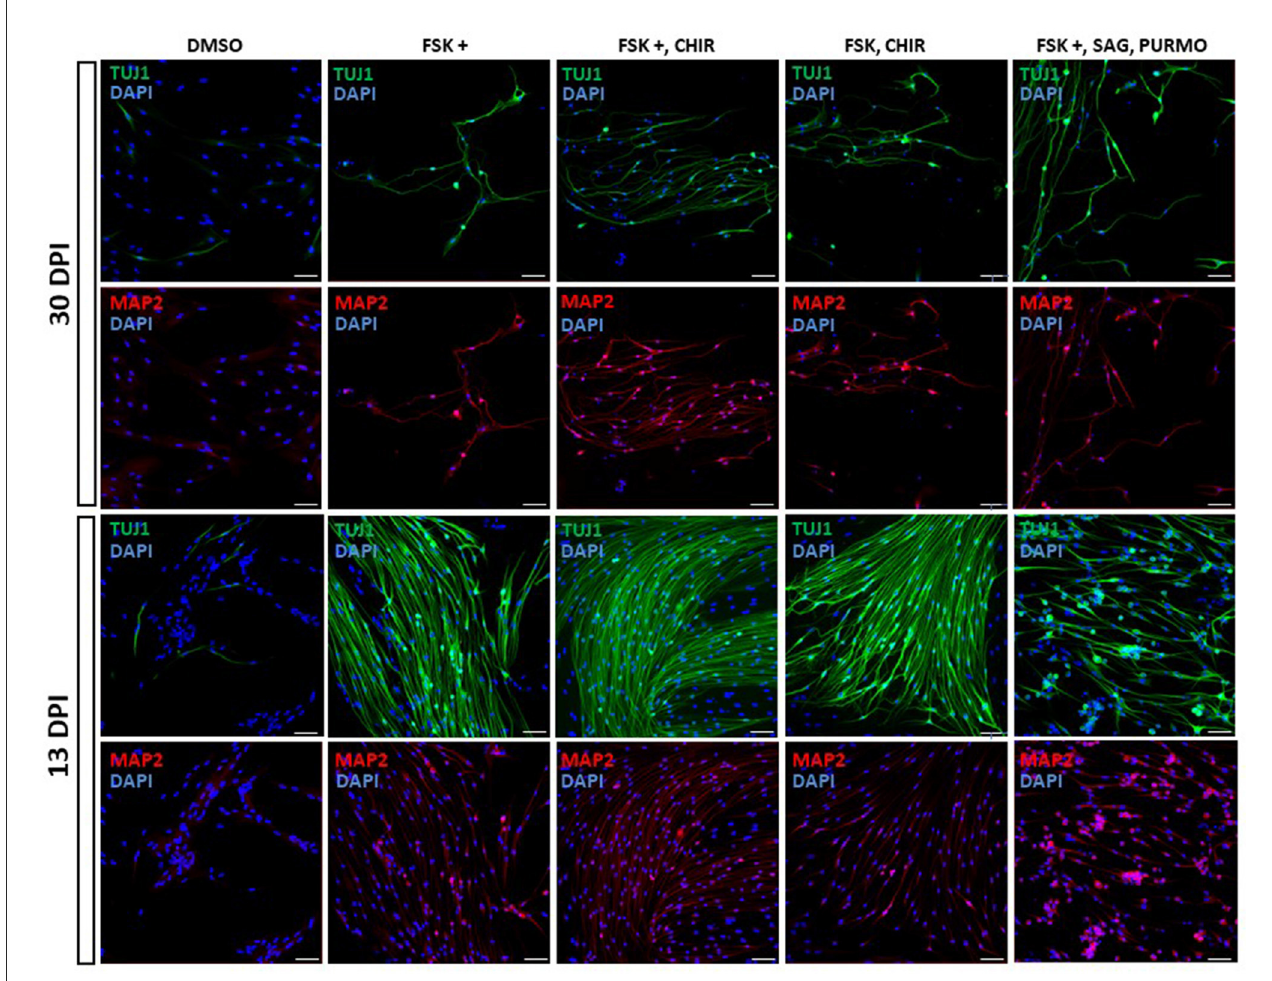
FIGURE4 Proneural genes expression in reprogrammed OEG-ROB cells. Expression analysis of neuronal markers was carried out by immunofluorescence after 13 and 30 days of induction with small molecules (see legend for cocktails and concentrations). In both conditions, OEG-ROB cells showed positive staining for Tuj1 (green) and for MAP2 (red) indicating a shift to neuronal fate. Cell number was compromised after 30 days of induction with small molecules but surviving cells changed their morphology, showing compact cell bodies and neurite-like structures. When time of induction was reduced to 13 days, cell viability increases and reprogrammed OEG-ROB cells aggregate into bundles. Nuclei were stained with DAPI (blue). For quantitative data, see Supplementary Figure 1. DPI, days post-induction; DMSO, DMSO 0.1%; FSK, forskolin 10 µ M; FSK + , forskolin 20 µ M; CHIR, CHIR99021 1.5 µ M; SAG, smoothened agonist 0.2 µ M; Purmo, purmorphamine 0.2 µ M; Scale bar: 50 µ